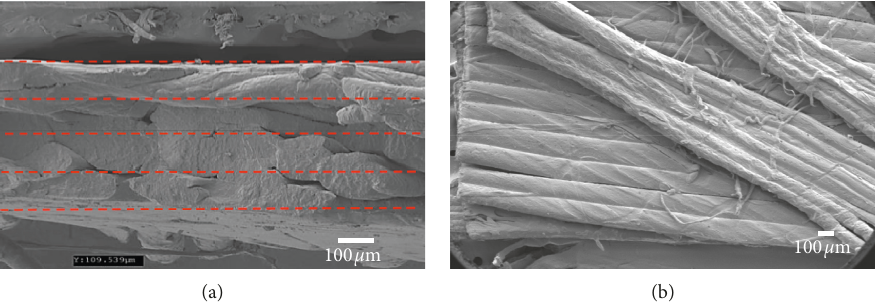
Figure 2: SEM image of the 3D helicoidal structure with 15 ° rotations between each layer. (a) SEM image showing cross section of the samples with a few stacked layers of fibre aligned at different direction at 95x magnification (the red-dashed lines are to indicate the boundary between layers), demonstrating of the basic feasibility to synthesize the full 3D helicoidal fibre structures similar to the natural material; (b) SEM image of the sample viewed from the